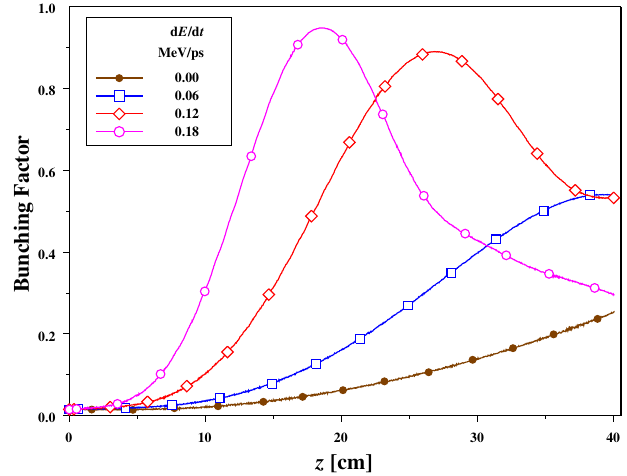
FIG. 6. (Color) Typical variations of bunching factor (31) along the interaction region. The simulations were carried out with (cid:15) 1 . T Q (cid:4) 10 pC and f s b